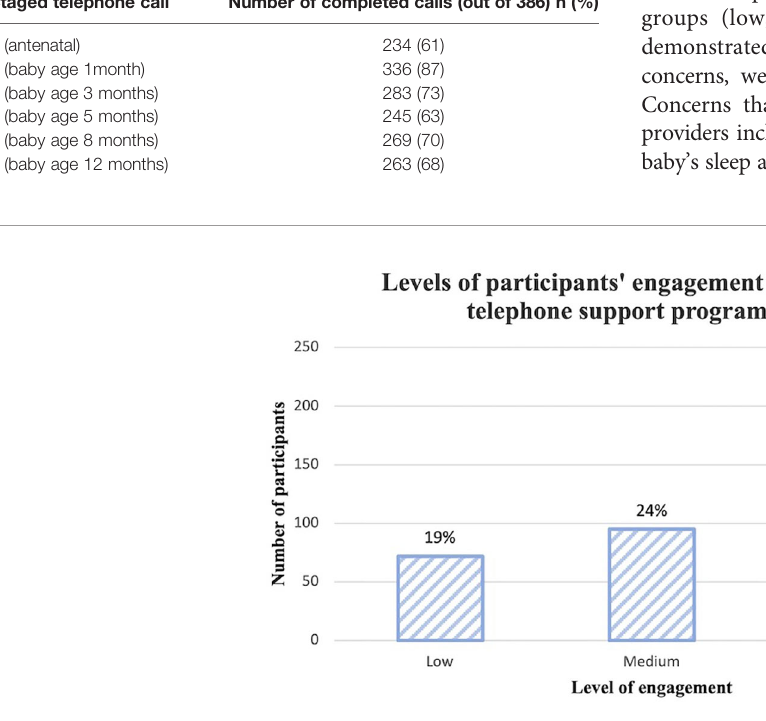
FIGURE 1 | Levels of participants ’ engagement with the telephone support